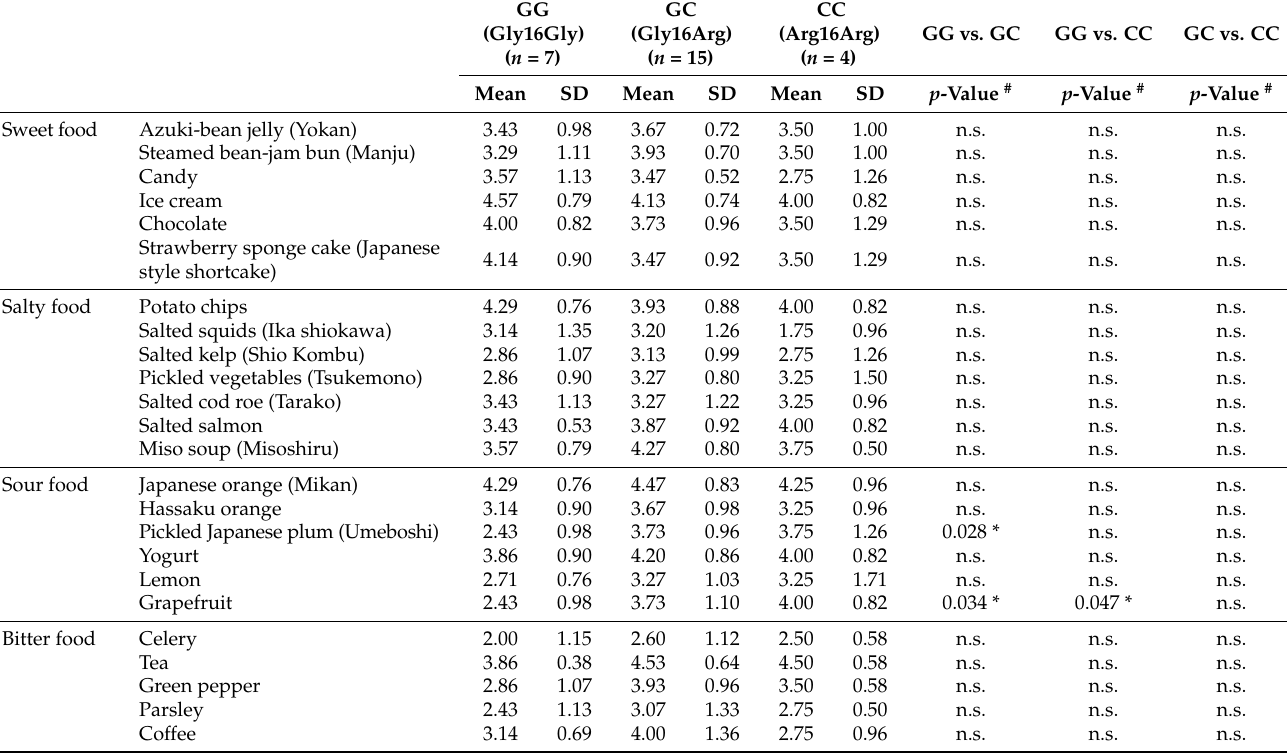
Table 4. Food preference in male subjects with the GG (Gly16Gly), GC (Gly16Arg), and CC (Arg16Arg) genotypes of ADRB2